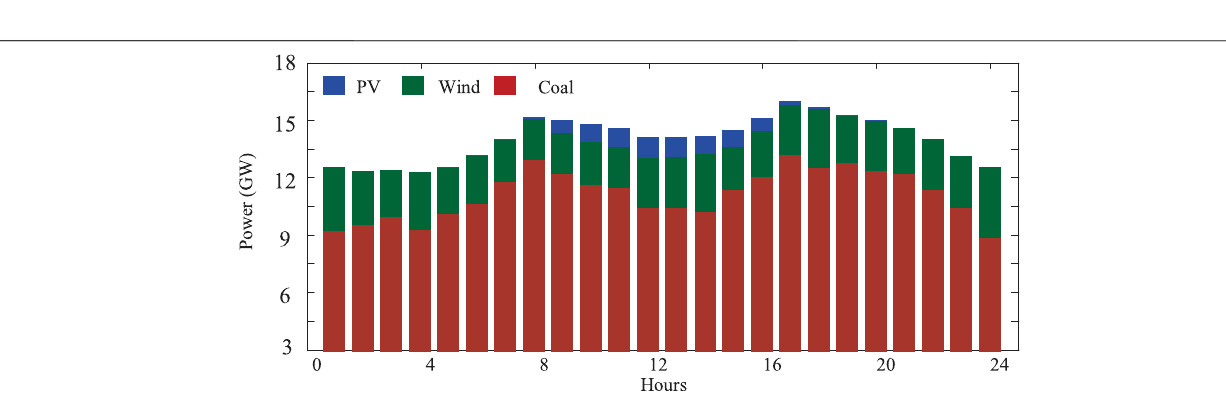
FIGURE 5 | Power components of the Heilongjiang power grid on a typical winter day in carbon reduction + scenario.